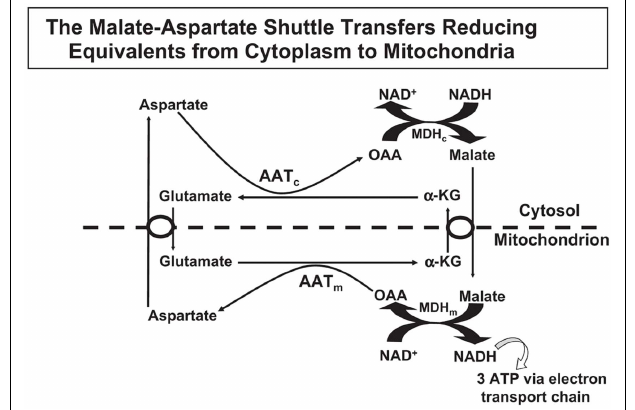
FIGURE 1 | In the malate–aspartate shuttle (MAS) cytosolic malate dehydrogenase (MDHc) oxidizes NADH and converts oxaloacetate (OAA) to malate (top right of figure), which enters the mitochondria in exchange with α -ketoglutarate ( α -KG) .The mitochondrial malate dehydrogenase (MDHm) re-oxidizes malate to OAA, which is transaminated to aspartate by the mitochondrial aspartate aminotransferase (AATm). Aspartate leaves the mitochondria in exchange with glutamate, requiring ACG (aralar or citrin). In the mitochondria glutamate conversion to α -KG is essential for AATm activity forming aspartate from OAA and delivering α -KG for mitochondrial export.The glutamate imported into the mitochondria had been formed by cytosolic aspartate aminotransferase (AATc) from α -KG after its entry into the cytosol.Without MAS activity NADH formed in the cytosol during glycolysis would have been unable to enter the mitochondria for oxidation. Reprinted from Hertz and Dienel (69), with